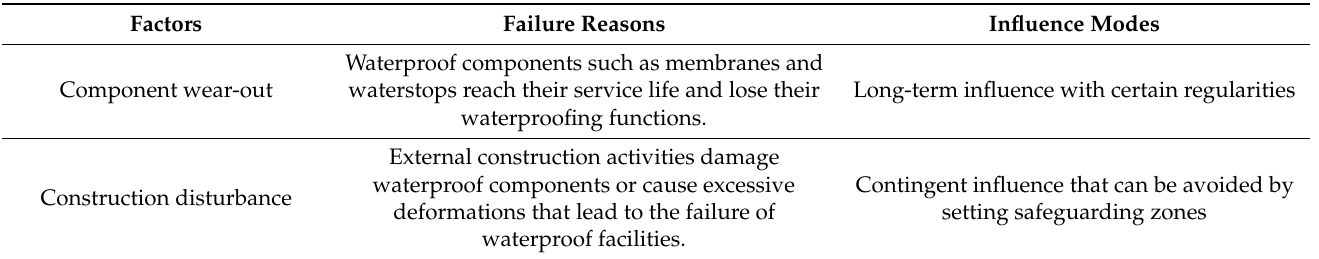
Table 2. Possible reasons for the failure of the joint waterproof facilities of cast-in-situ utility